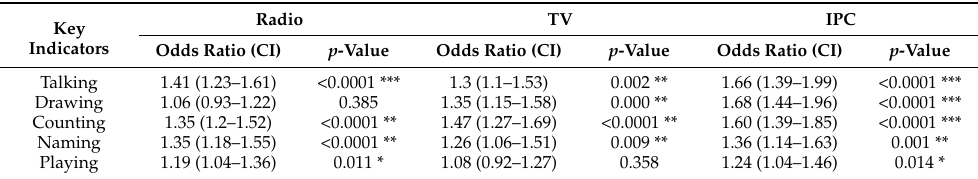
Table 4. Regression Analysis for Primary Caregiver’s Exposure to Radio, TV, and IPC Intervention and Key Practice Indicators, n = 4996.